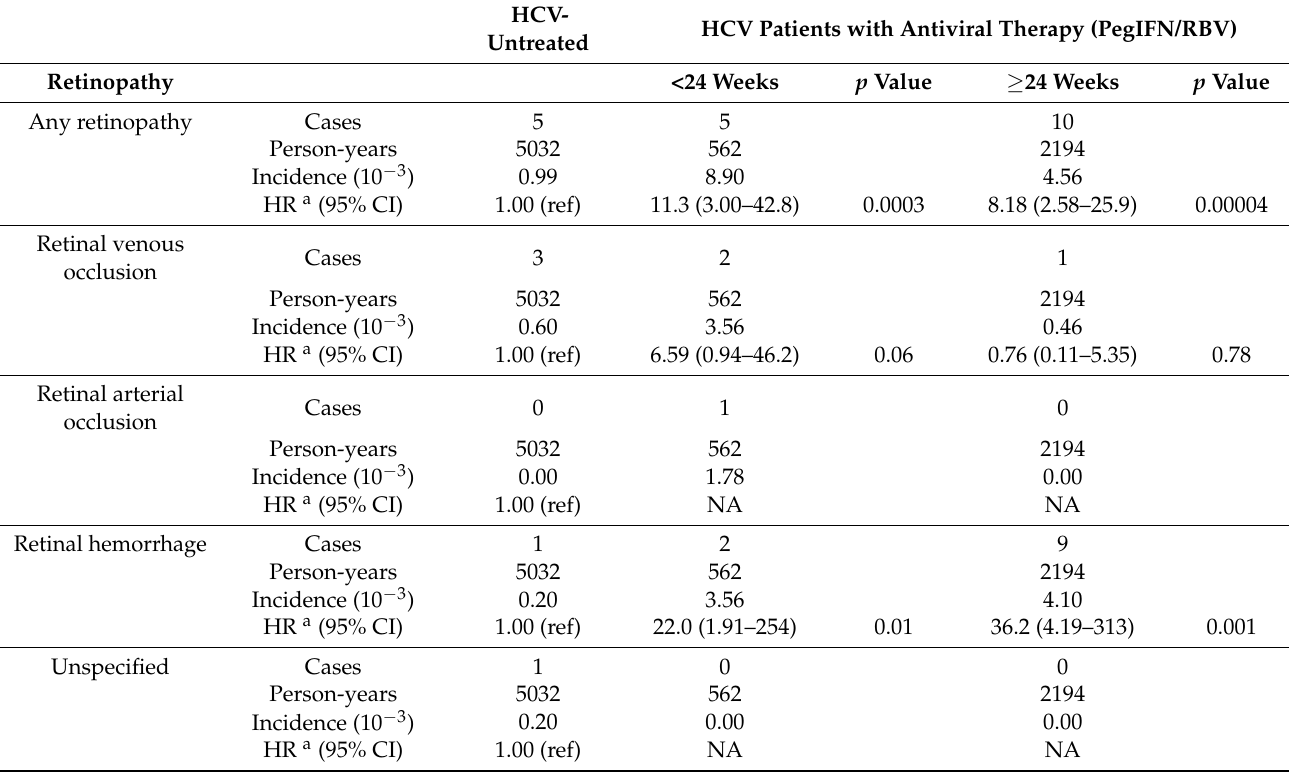
Table 3. Risk of retinopathy associated with anti-HCV therapy and treatment duration. HCV-